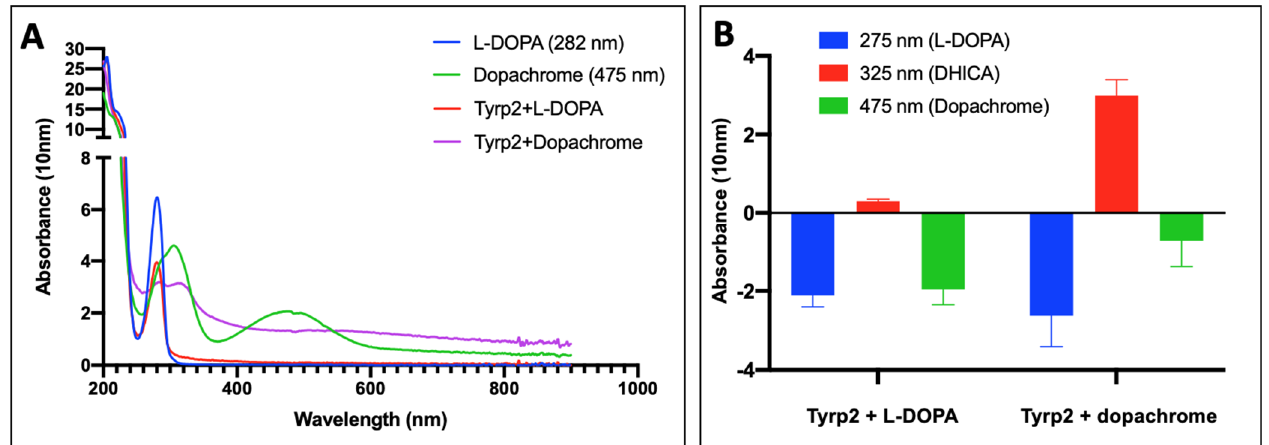
Figure 3. Enzymatic activity of Tyrp2. ( A ) The spectrum that represents the recorded wavelengths from 200–900 nm for L-DOPA (blue), dopachrome (green), Tyrp2 in the presence of L-DOPA (red), and Tyrp2 in the presence of dopachrome (purple) over three separate experiments. ( B ) A graph that represents the 30 min reaction of Tyrp2 in the presence of L-DOPA (bars 1–3 from left) or dopachrome (bars 4–6 from left) measured at 275 nm (L-DOPA, blue bars), 325 nm (DHICA, red bars), and 475 nm (dopachrome, green bars) over three separate experiments with the baseline subtracted. The error bars represent the standard error of the mean (SEM).